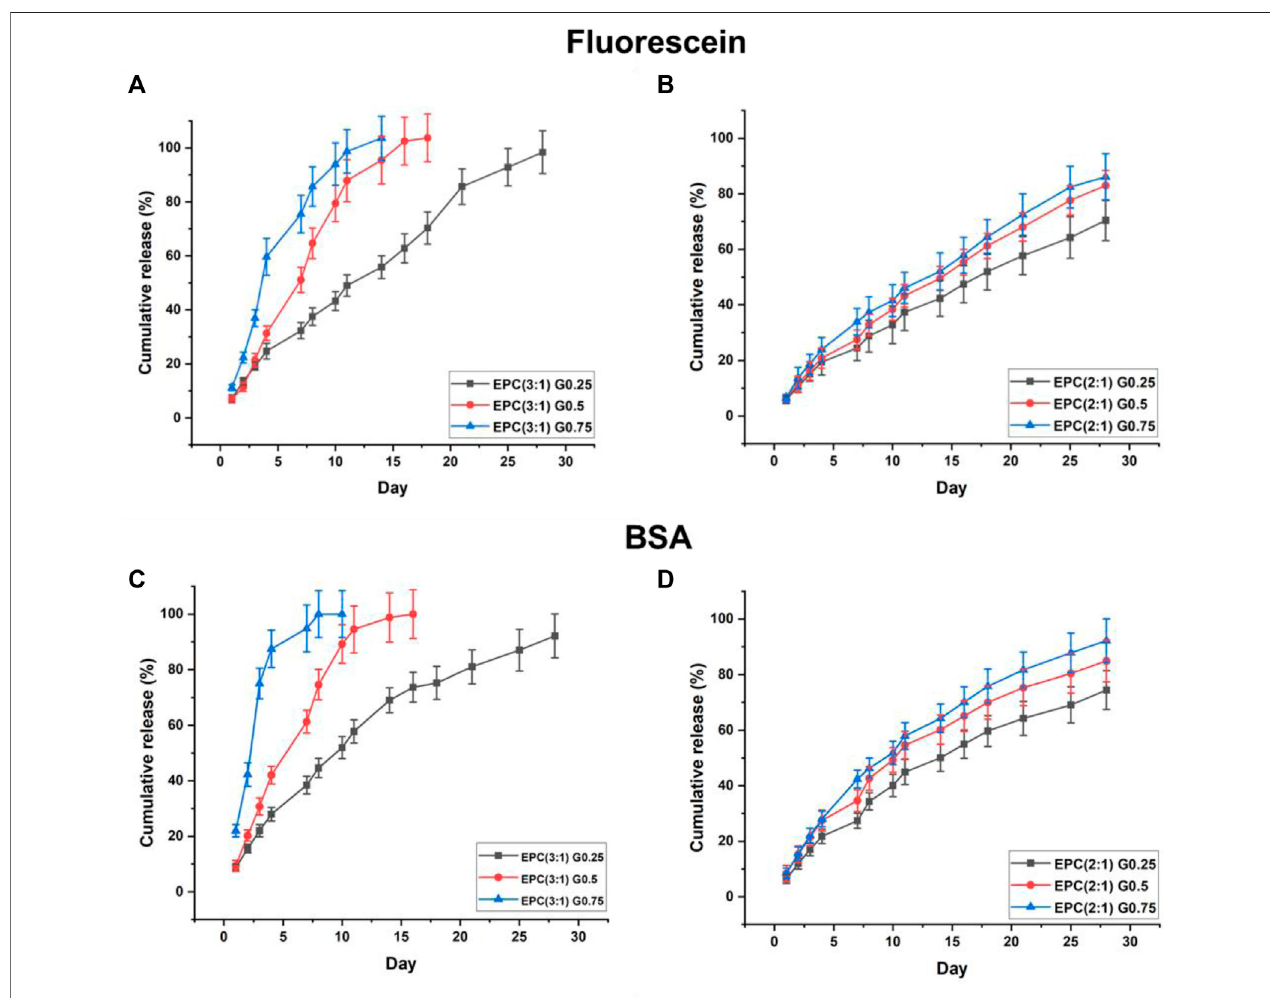
FIGURE6| Sustainedreleaseofmodelhydrophobicdrug, fl uorescein,from (A) EPCG(3:1)and (B) EPCG(2:1)seriesofthermogelsandsustainedreleaseofmodel hydrophilic protein, BSA, from (C) EPCG(3:1) and (D) EPCG(2:1) series of thermogels.